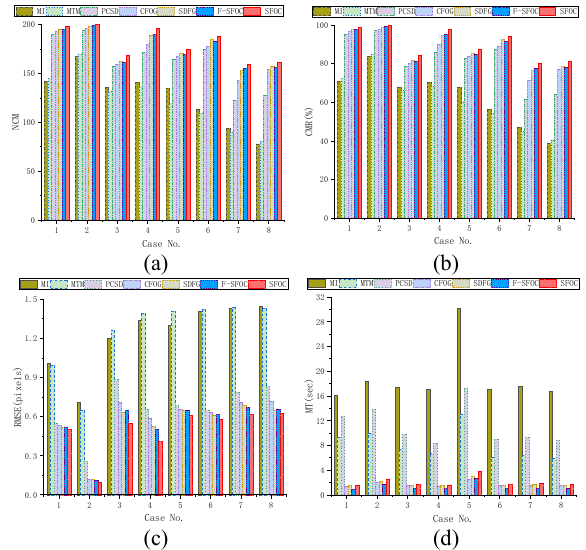
Figure 5. Performance comparison of different methods on the eight multimodal image cases with the template size of 80 × 80 pixels. (a) NCM. (b) CMR. (c) RMSE. (d)